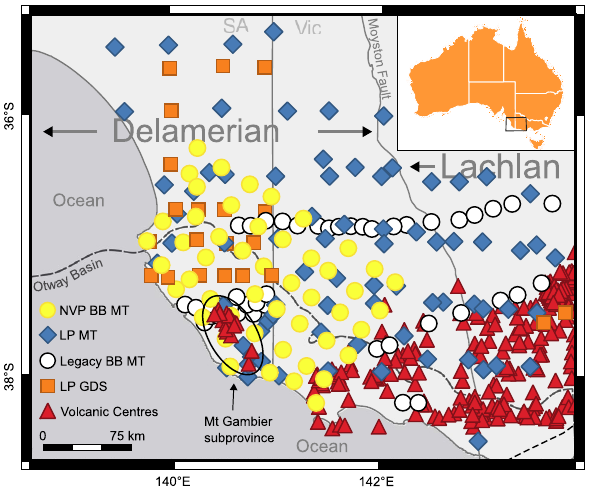
Figure 1. Tectonic setting of the study area displaying the major structural boundaries and outline of the Otway Basin. The east-dipping Moyston Fault represents a major crustal-scale boundary between the older Delamerian and younger Lachlan orogenic belts. The Otway Basin is a large, Late Jurassic rift basin that trends predominantly NW–SE and covers both onshore and offshore South Australia/Victoria as well as offshore Tasmania. Red triangles indicate volcanic centres of the Newer Volcanics Province 3 . The Mt Gambier subprovince (circled) can be further subdivided into the Mt Burr Group (NW) and the Mt Gambier/Mt Schank group (SE). All MT and GDS data shown were used in the 3D inversion. Yellow circles—broadband MT sites as part of this paper, white circles—previously collected broadband MT, blue diamonds—AusLAMP and other long-period MT, orange squares—geomagnetic depth soundings. Visualisation created using the free and open source QGIS v3.22.8 (https:// qgis.